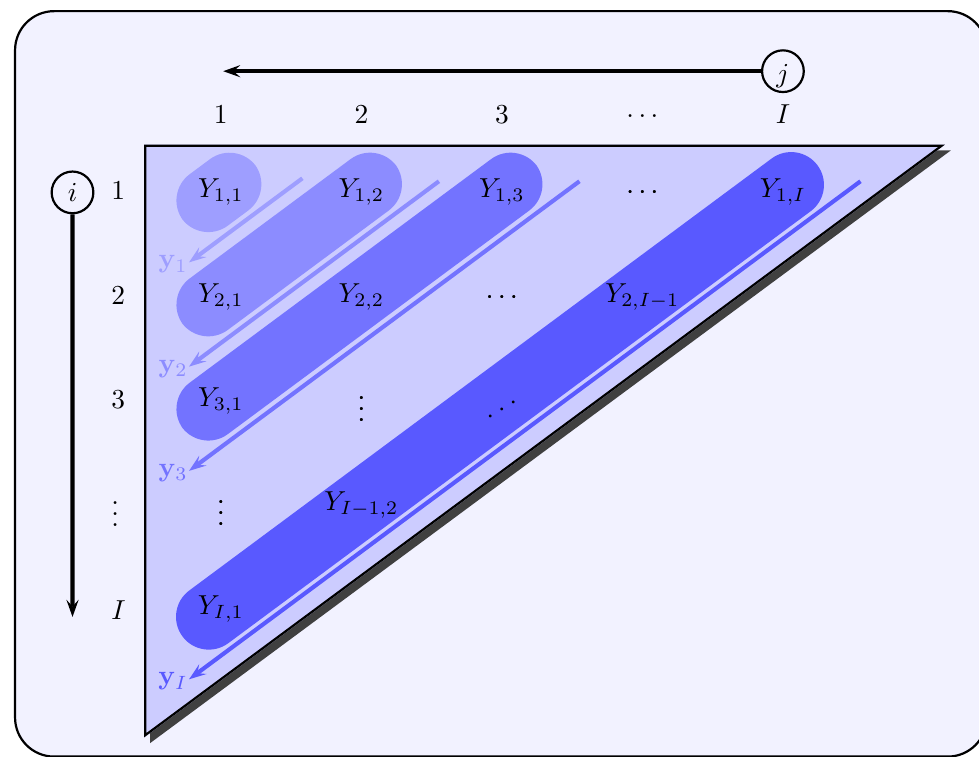
Figure 6. Modeling the observation vector in Verrall